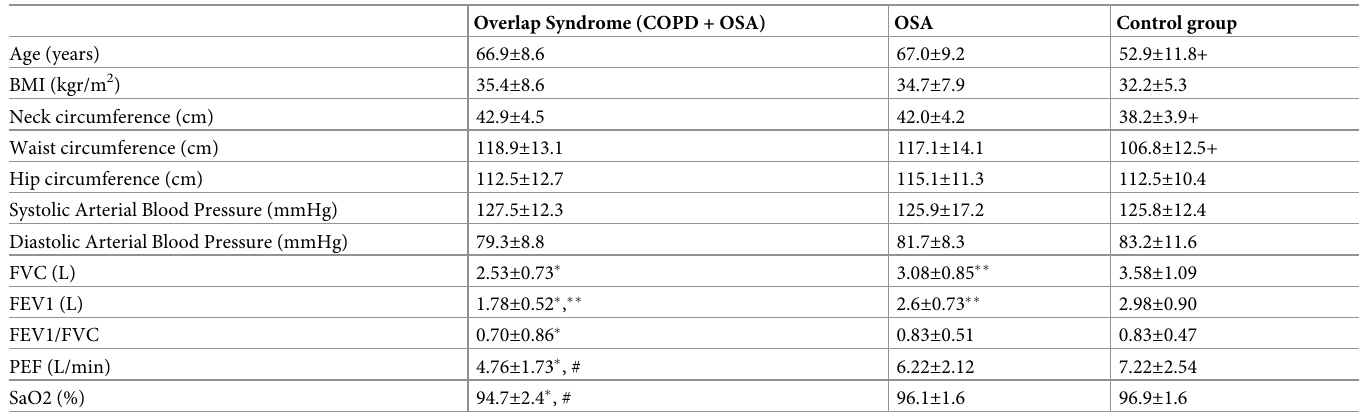
Table 1. Baseline characteristics of the study groups (mean±SD).